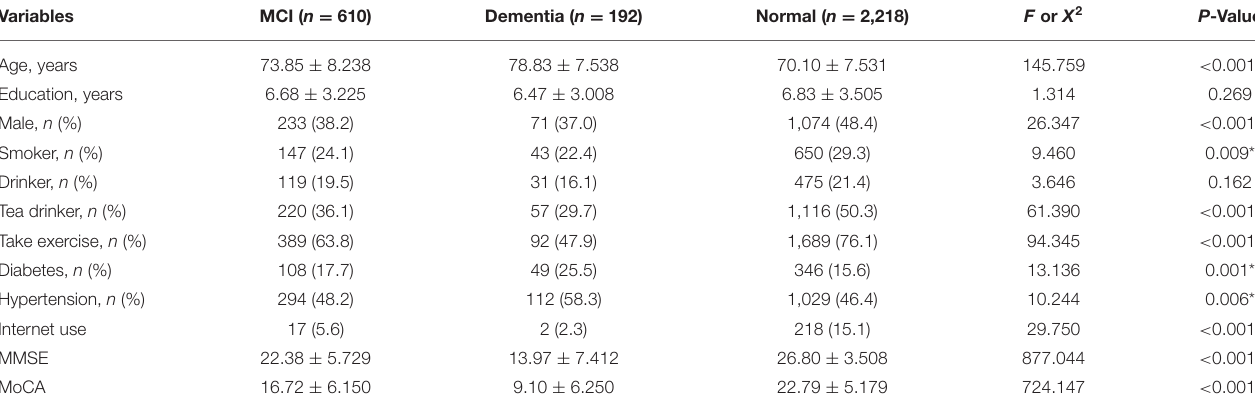
TABLE 1 | Comparison of baseline general demographic and cognitive characteristics among different cognitive populations.